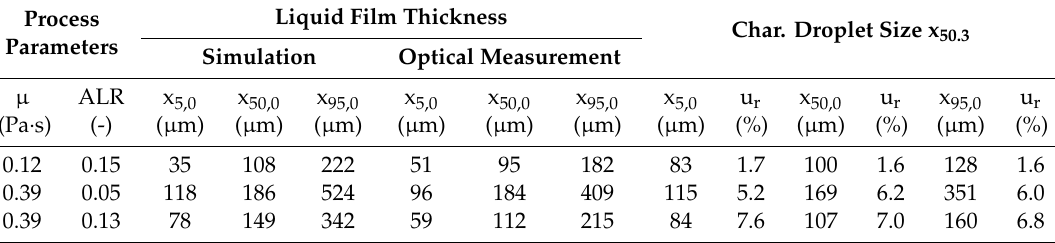
Table 3. Characteristic values of the characteristic droplet size x 50,3 and of the time dependent distribution of the liquid film thickness from simulation and optical measurement in dependency of the process parameters